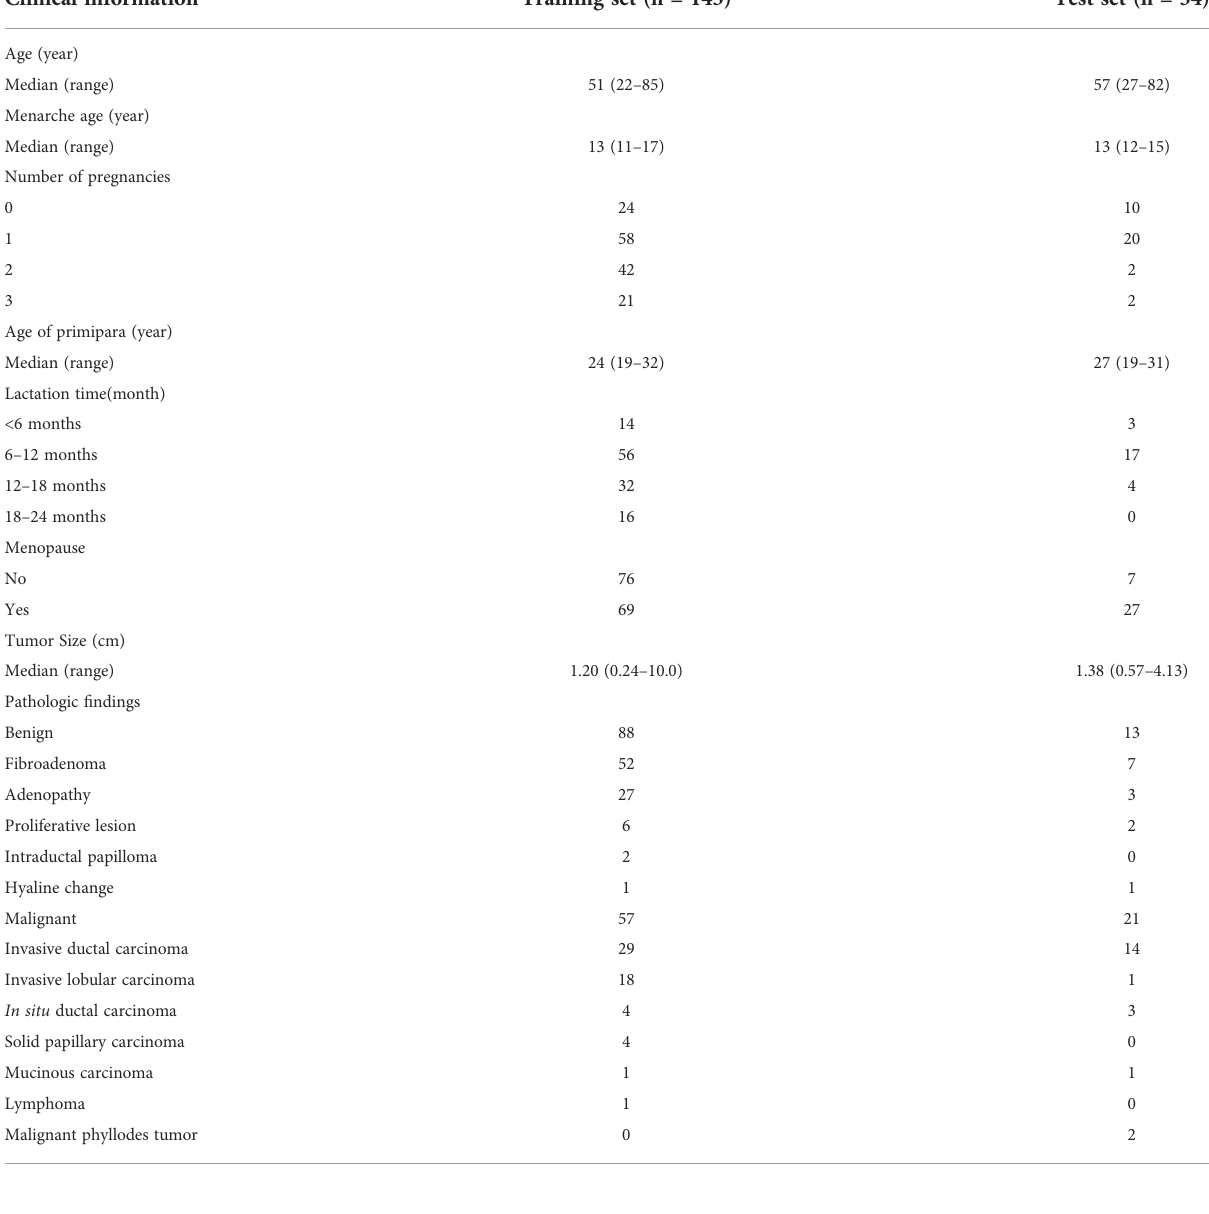
TABLE 1 Clinical information and pathological results of the patients.